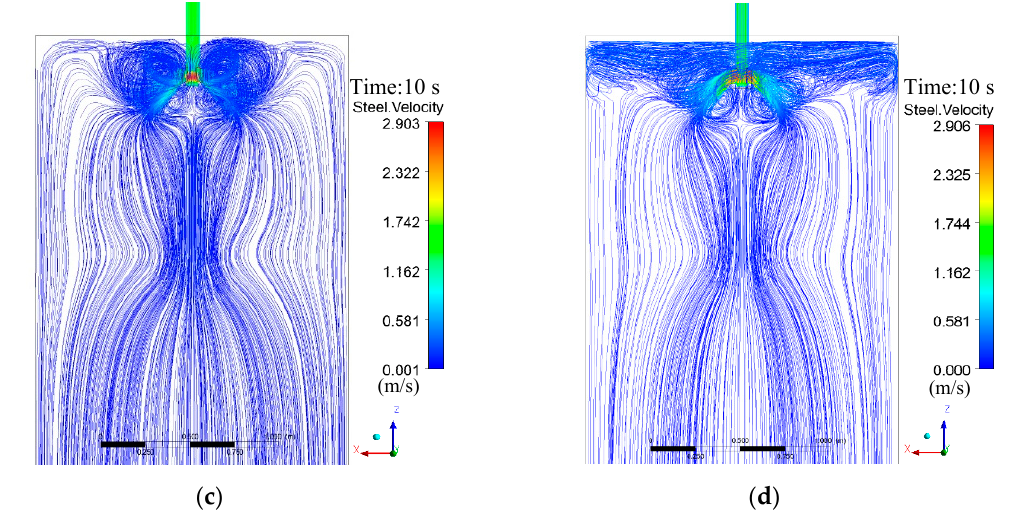
Figure 5. Comparison of steel flow patterns in the slab mold with different electromagnetic conditions: ( a ) without electromagnetic driving; ( b ) with EMS; ( c ) with EMBr; ( d ) with multifunction electromagnetic driving.